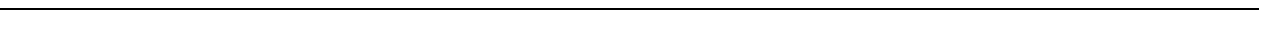
Fig. 2 Cas5 regulatory network is rewired in response to caspofungin treatment. a , b Heat maps comparing Cas5-dependent genes with caspofungin- regulated genes. a The left heat map shows the overlap of genes with Cas5-dependent increased RNA PolII binding with (+) and without ( − ) caspofungin treatment. Cas5-dependent genes are indicated by a solid blue line . The right heat map indicates those genes with increased binding ( red ) and decreased binding ( blue ) in a wild-type strain upon caspofungin treatment. b The left heat map shows the overlap of genes with Cas5-dependent reduced RNA PolII binding with (+) and without ( − ) caspofungin treatment. Cas5-dependent genes are indicated by a solid red line . The right heat map indicates those genes with increased ( red ) or decreased ( blue ) RNA PolII binding in a wild-type strain upon caspofungin treatment. c Bar graph showing the relative percentage of Cas5-dependent genes speci fi c to basal conditions ( blue bars ), speci fi c to caspofungin treatment ( red bars ), or common to both conditions ( white bars ) in the indicated KEGG pathways. The total number of genes belonging to each KEGG pathway are indicated. Only selected KEGG pathways are shown based on number of genes enriched for PolII binding either under basal or caspofungin conditions. See Supplementary Data 4 for complete data set. d Venn diagram depicting number of genes differentially bound in a cas5 Δ / cas5 Δ mutant relative to wildtype under basal conditions (increased, red ; decreased, blue ) and genes responding to caspofungin treatment in a wild-type strain (increased, green ; decreased, yellow ). The 131 genes highlighted in red text represent the substantial fraction of the genes with Cas5-dependent increase in RNA PolII binding under basal conditions that have reduced PolII binding